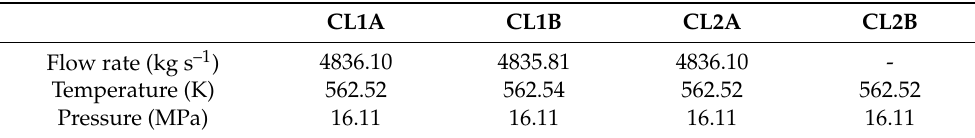
Table 1. Initial transient conditions for CFD calculation.